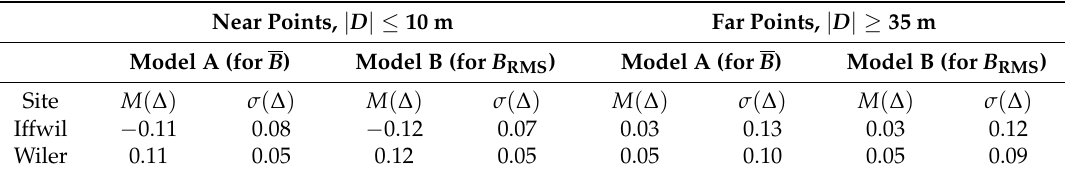
Table 3. Statistics (mean M ( ∆ ) and standard deviation σ ( ∆ ) ) of the difference between model and measurement, separately for near and far points for models with the DHM25.